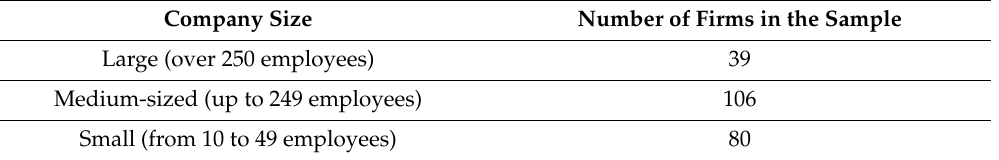
Table 1. Sample distribution by firm